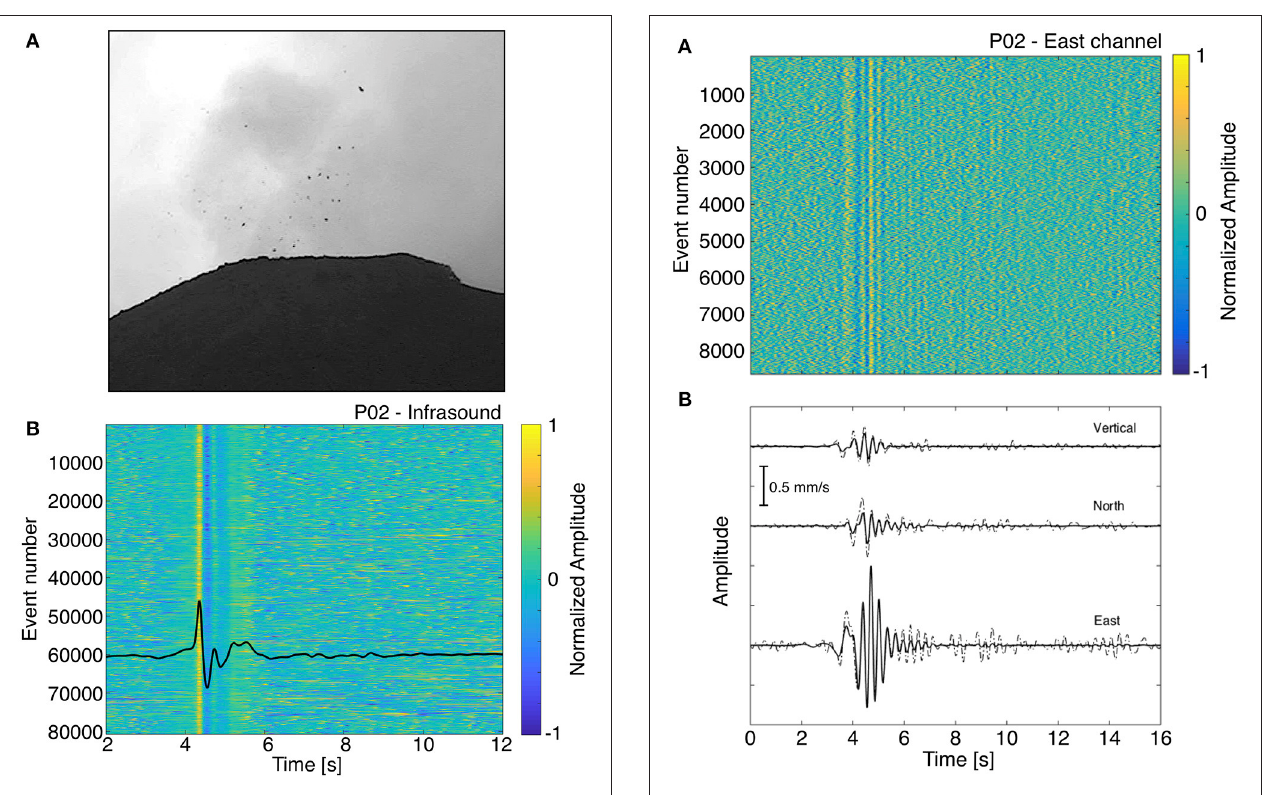
FIGURE 2 | (A) Single frame from a video-recording of one small explosion at the crater recorded on November 3, 2013. The video camera was positioned on Cerro Chino at about 1km NNW of the Mackenney cone (see black circle in Figure 1 ). (B) Waveforms of 80,701 events on the infrasonic record over a 10-day long period from 31 October to 11 November 2013, normalized to the maximum absolute amplitude. Plotted in black is the stacked infrasound template event used in the matched filter approach.